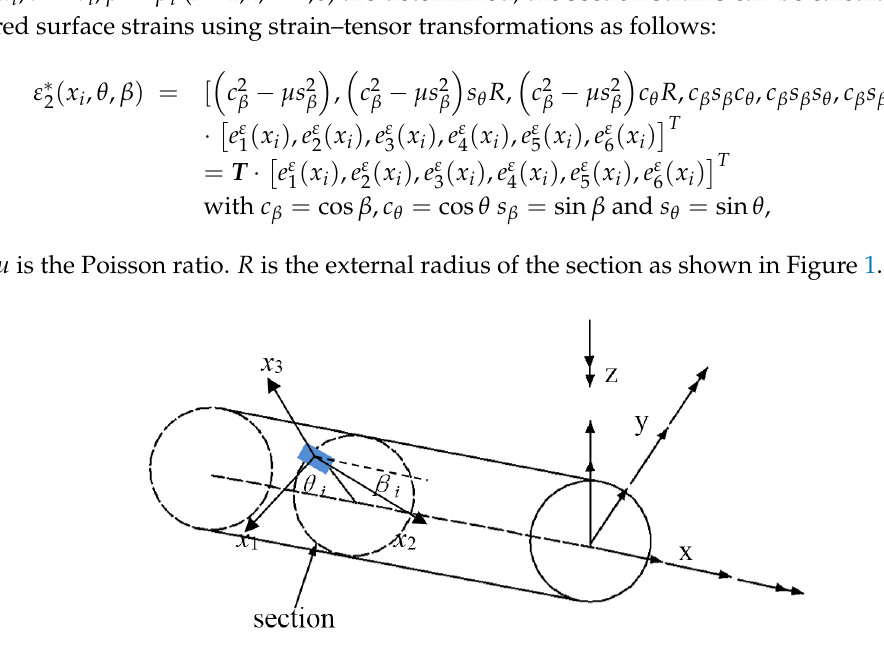
Figure 1. Location of the strain sensor placed on the beam external surface.